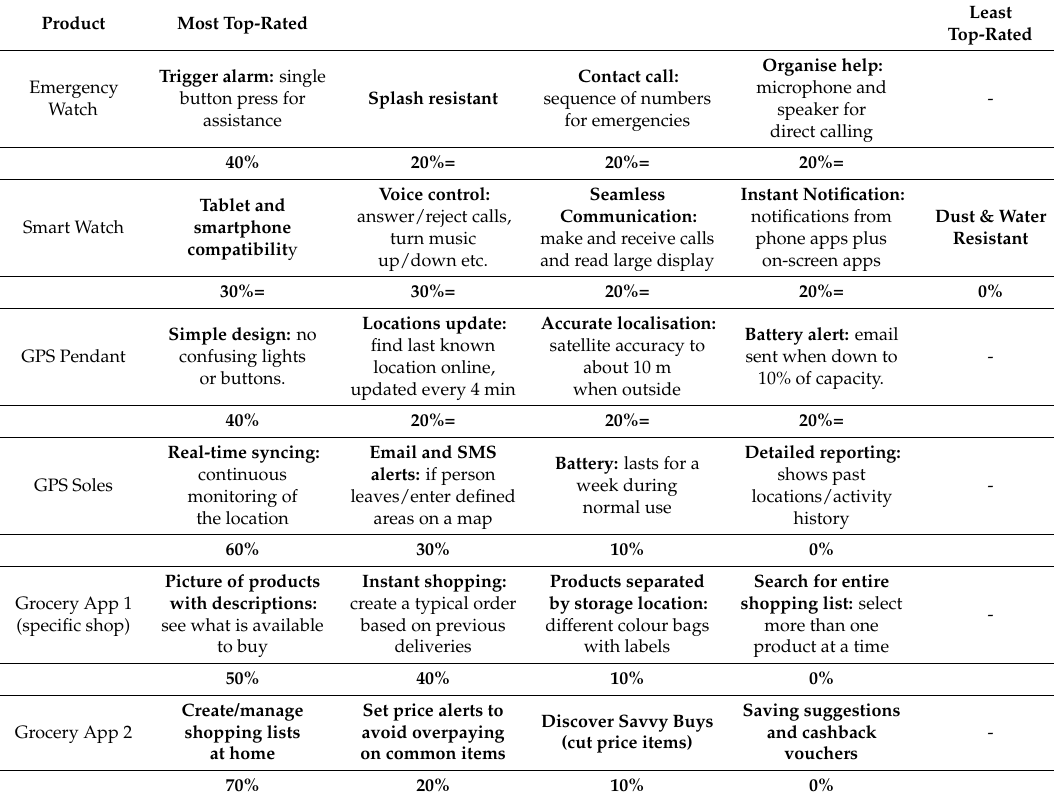
Table 4. Paired product features ordered by frequency of top-rating by the carers ( n = 10). Product